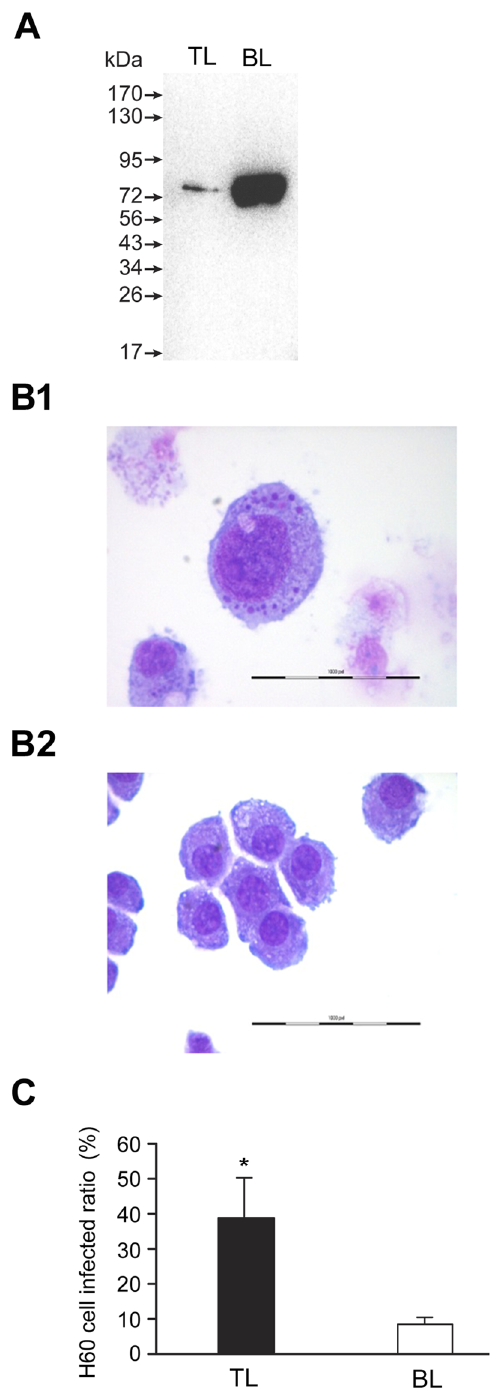
Figure 2. The presence of DCs and RCs assessed in the TL and BL of the renografin purified E . chaffeensis fractions. ( A ) Western blot analysis performed with ClpB polyclonal antibody which revealed higher levels of the protein expression in the BL derived bacterial fraction proteins; ( B ) cell-free E . chaffeensis recovered from TL and BL assessed for reinfection of naïve Vero cells; infection was detected only with the fraction derived from the TL ( B1 ), but not in the BL ( B2 ) ( C ). Infectivity of fractionated Ehrlichia organisms from the TL and BL was further confirmed by measuring the numbers of infected cells following incubation for three days following inoculation into naïve HL60 cultures. Infectivity with TL-derived Ehrlichia was significantly more than BL derived